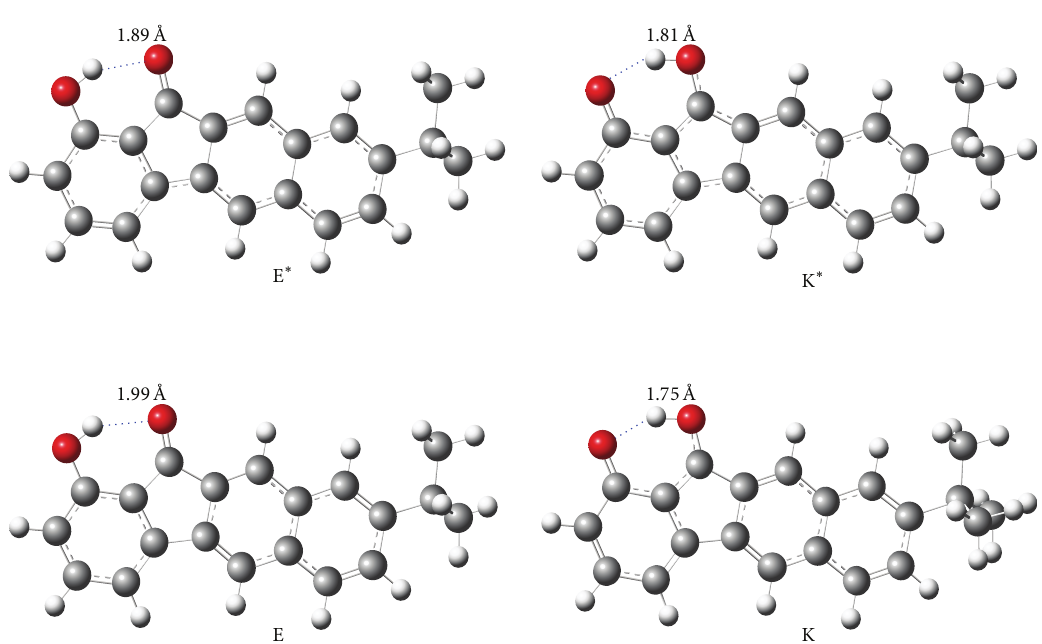
Figure 4: The optimized geometric structures of enol (E) and keto (K) form for 1 in the ground and the first singlet excited state together with the intramolecular hydrogen bond lengths.